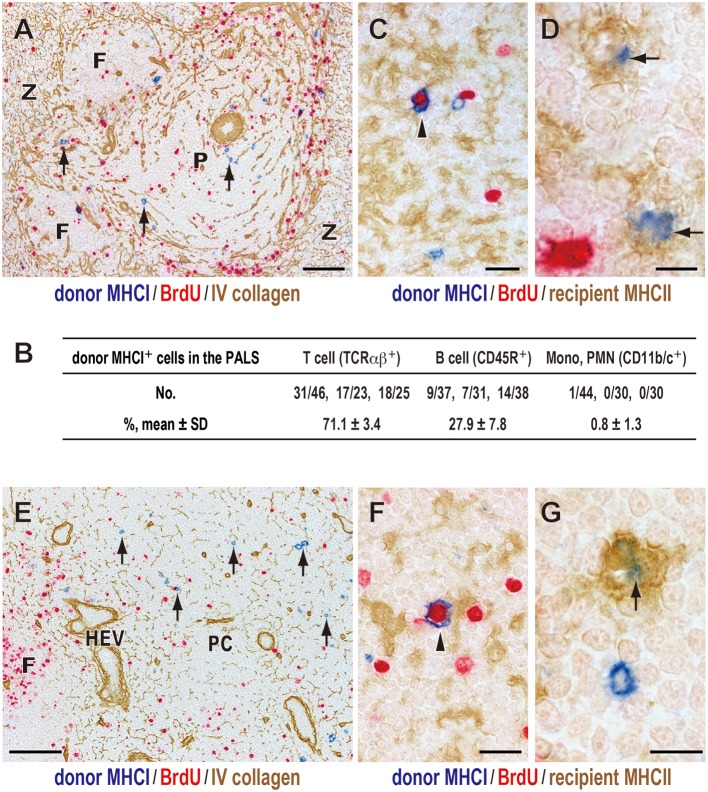
Fate of donor T cells after DST. Three-color immunostaining of recipient spleens (A–D) or peripheral LNs (E–G) for donor MHCI (blue), BrdU (red), and type IV collagen (brown) or recipient MHCII (brown). (A,E) Donor MHCI+ cells (arrows) were observed in the PALS (A) and T cell area of the LNs (paracortex, PC) (E) at day 1. (B) Phenotype of donor MHCI+ cells and cell ratio in the PALS. Approximately 100 donor MHCI+ cells/rat were examined (n = 3). Donor MHCI+ cells that migrated to the PALS were TCRαβ+ T cells (~70%) and CD45R+ B cells (~30%). (C,F) A donor cell binding to MHCII+ putative recipient DCs (brown) became BrdU+ (arrowhead) in the PALS (C) and the PC (F) at day 1, representing a graft vs. host reaction. (D,G) Donor MHCI+ fragments (blue) superimposed on the cytoplasm of recipient putative DCs (arrows) in the PALS (D) and the PC (G) at day 2, suggesting phagocytosis. F, lymph follicle; P, splenic PALS; Z, marginal zone; HEV, high endothelial venule. Scale bar = 100 μm (A,E), 20 μm (C,F), or 10 μm (D,G).